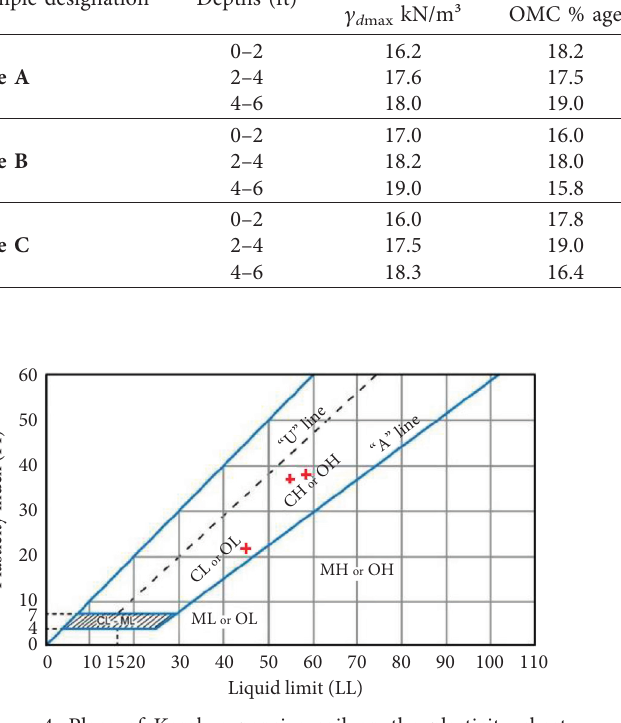
Figure 4: Place of Karak expansive soil on the plasticity chart (average values).